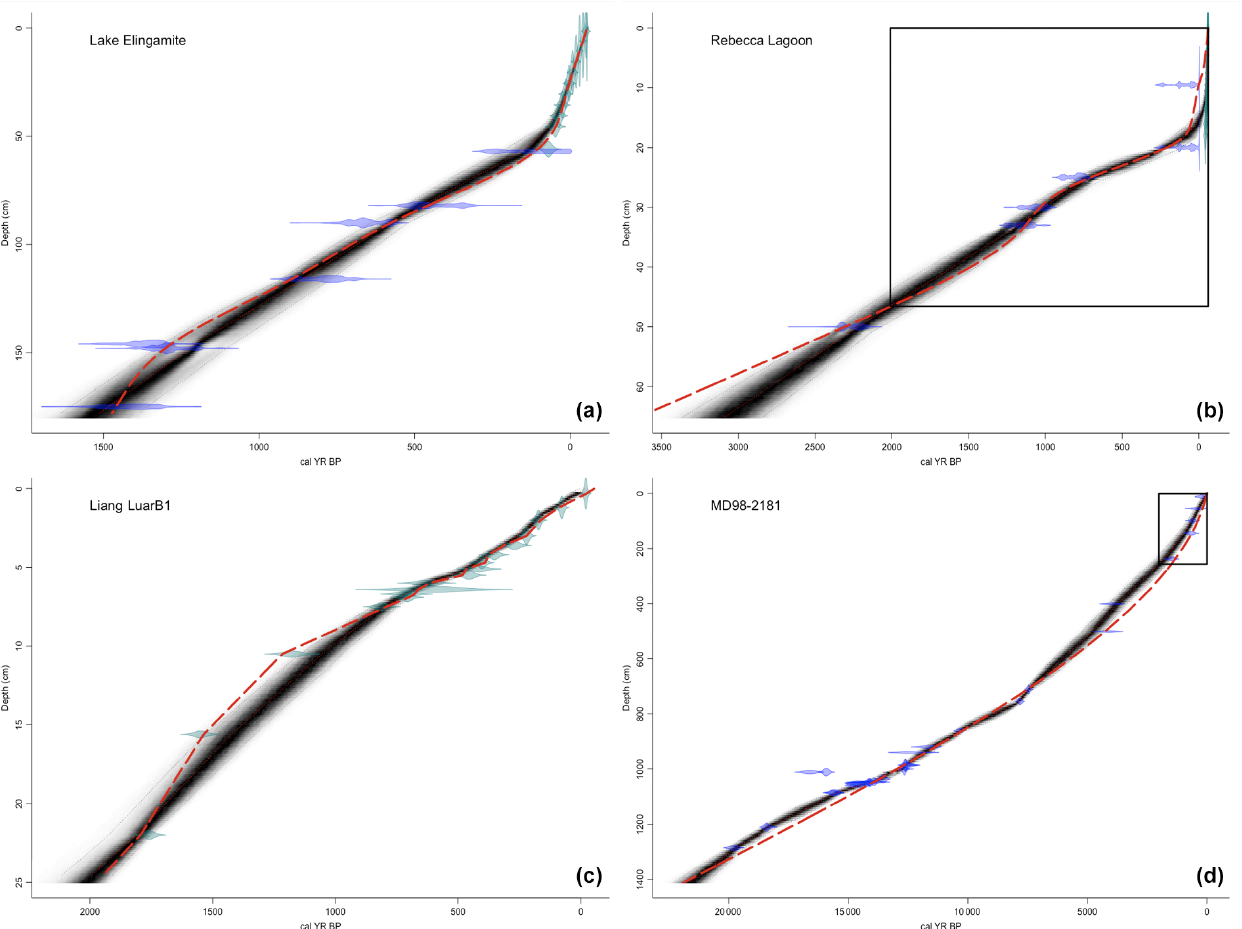
Figure 4. Examples of bacon outputs for recalibrated age–depth models for (a) Lake Elingamite; (b) Rebecca Lagoon; (c) Liang Luar Cave; (d) marine core MD98-2181. Originally published age–depth relationships were retrieved from public archives (Table 1) and are displayed by a dashed red line. The Common Era is highlighted by a black rectangle in records that extend beyond the last 2000